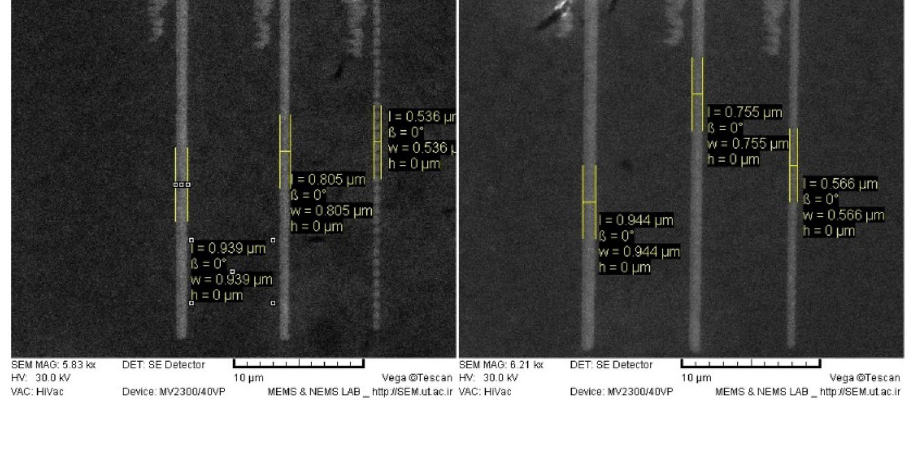
Fig. 7 Simulation of a remov- ing titanium film by wet etching, and b ion exchange process in molten salt (AgNO